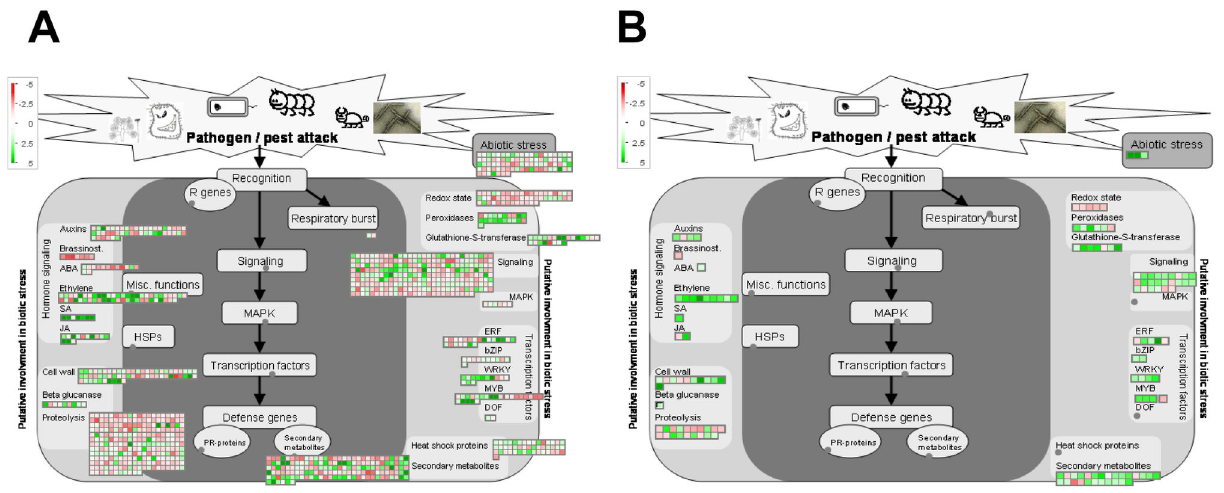
MapMan illustration depicting the transcripts from the “Biotic stress” BIN regulated under pathogenic conditions. Transcriptomic data from bacteria-inoculated leaves were compared to their respective controls (mock-inoculated). Genes that were shown to be differentially expressed were mapped using the MapMan software (http://mapman.gabipd.org). Picture shows genes related to biotic stress regulated in MG-20 (A) and Gifu (B). Log fold change ratios are indicated as a gradient of red (down-regulated) and green